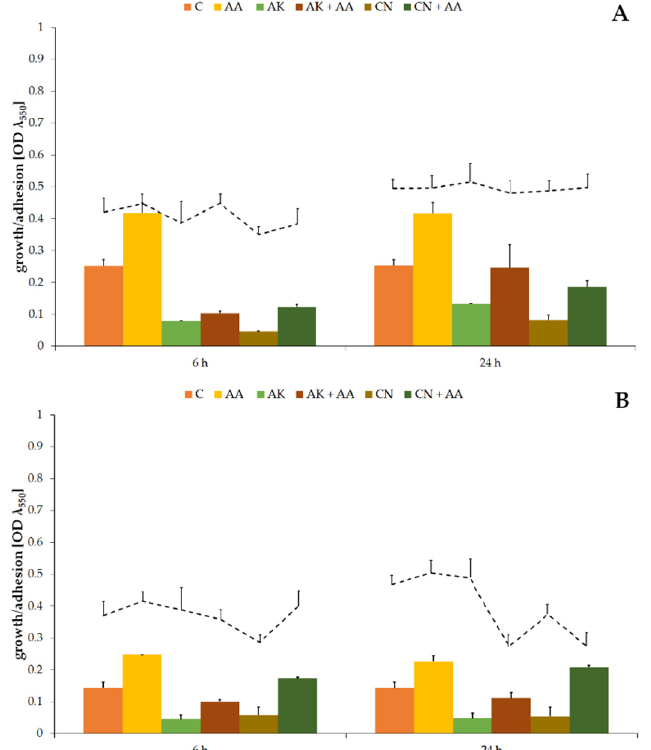
Figure 1. The bacterial growth (column graphs) and cell adhesion to the catheter (line graphs) of the P. mirabilis ATCC 29906 ( A ) and C12 ( B ) strains after 6 and 24 h of cultivation. Legend: C—control, AA—ascorbic acid, AK—amikacin, CN—gentamicin.